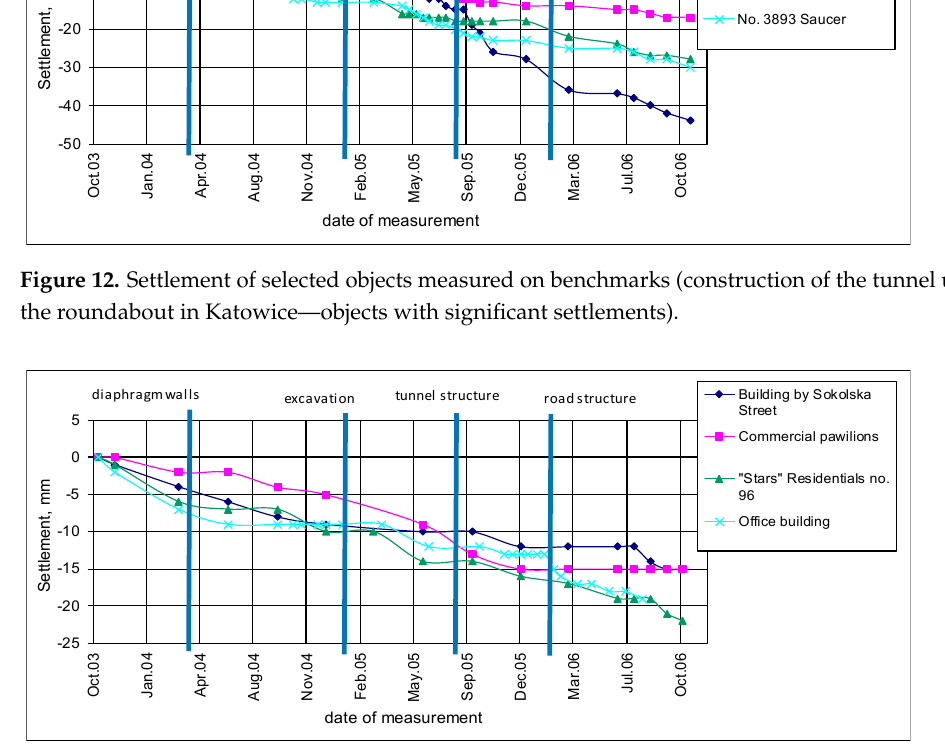
Figure 11. Change in water level measured in individual piezometers (construction of the tunnel